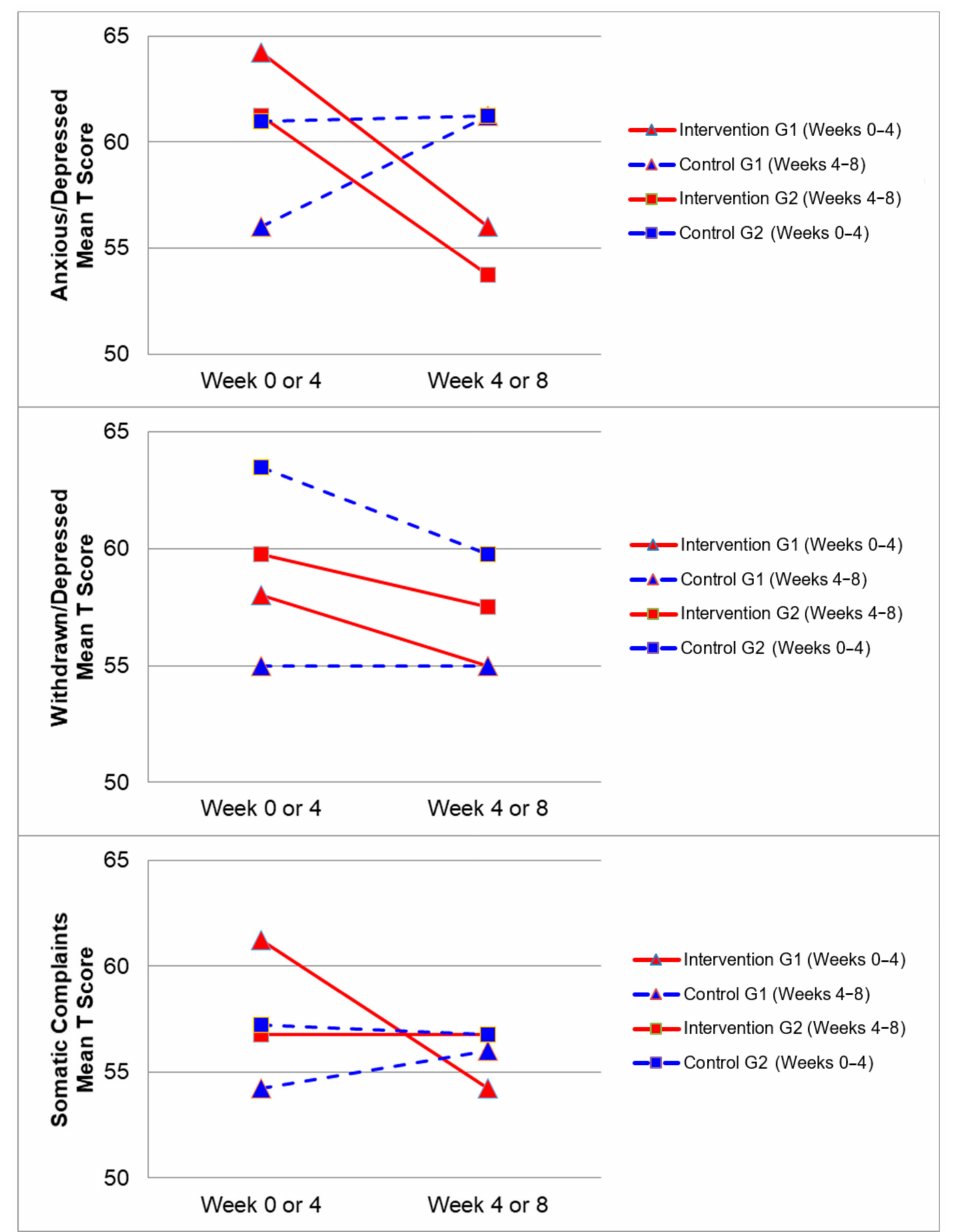
Figure 2. Mean t score changes within Group 1 (G1) and Group 2 (G2) based on intervention vs. control periods for anxious / depressed, withdrawn / depressed, and somatic complaints